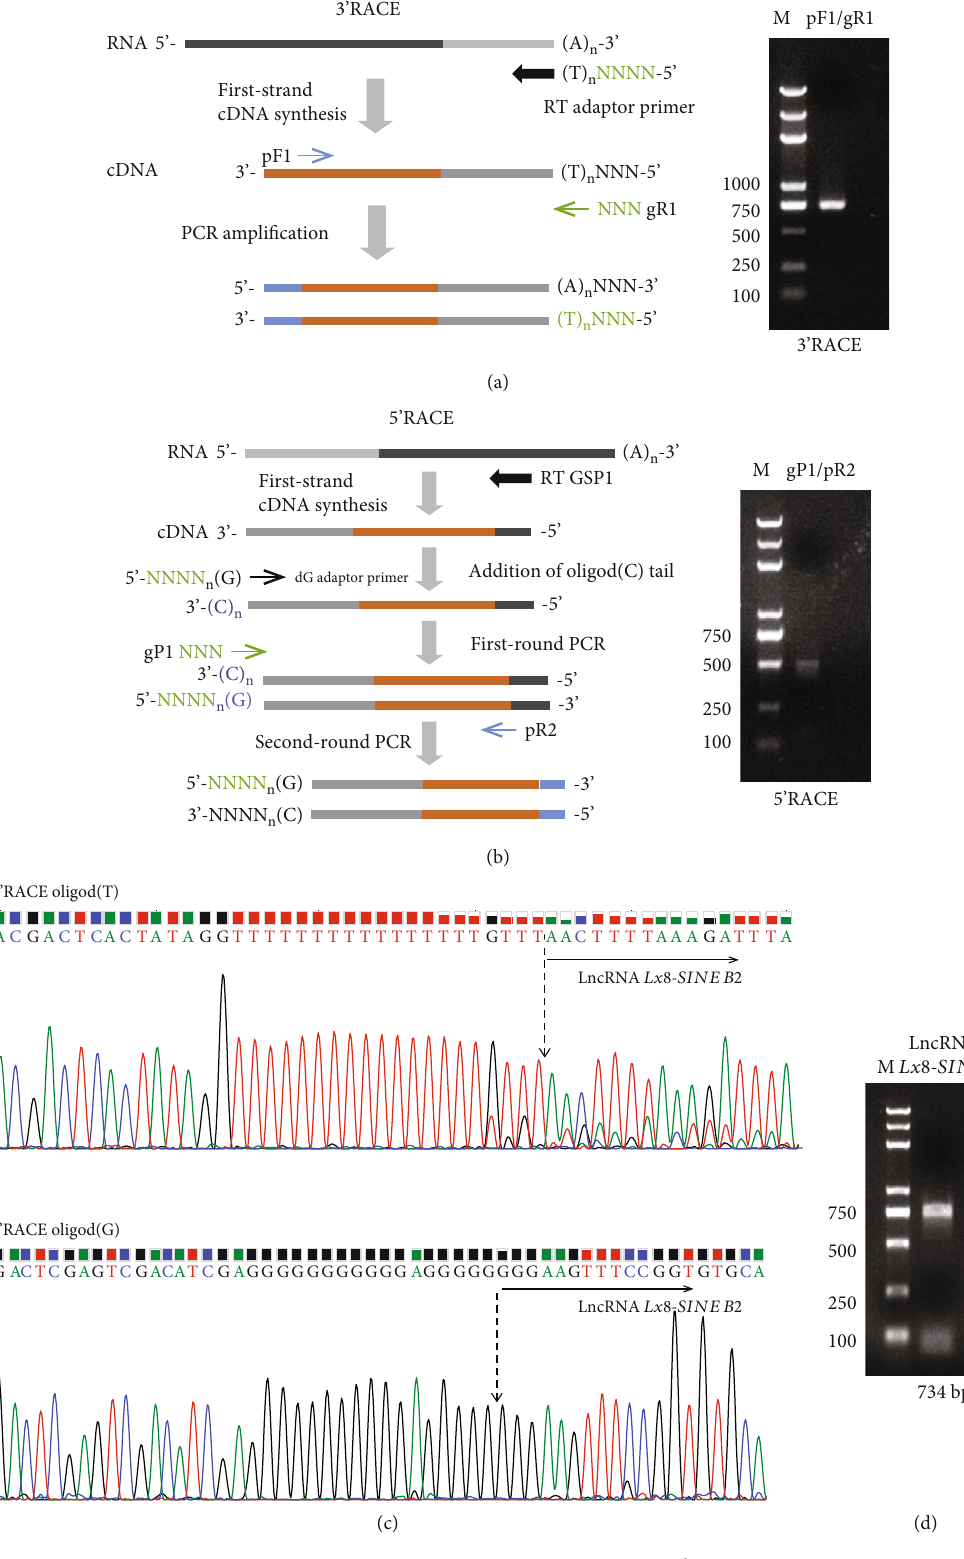
Figure 1: Mapping the full-length sequence of lncRNA Lx8-SINE B2 . (a) Schematic of the 3 ′ -rapid ampli fi cation of cDNA ends (RACE) (left) and 3 ′ RACE result for lncRNA Lx8-SINE B2 (right). (b) Schematic of the 5 ′ RACE and its result for lncRNA Lx8-SINE B2 . (c) DNA sequencing of RACE using a universal primer in pEASY-T1 vector. (d) Validation of lncRNA Lx8-SINE B2 transcript size by PCR from cDNA. M, DNA